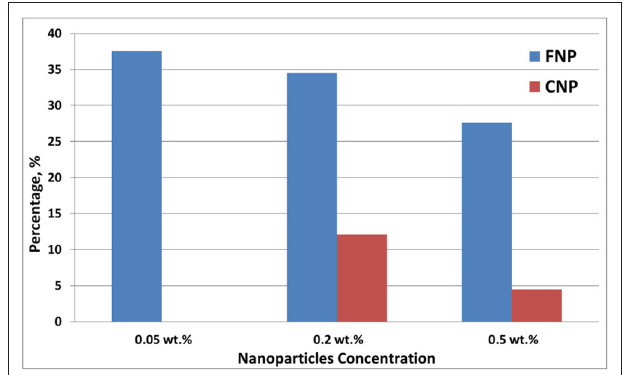
FIGURE 13 | Percentage of adsorbed nanoparticles inside core plug.